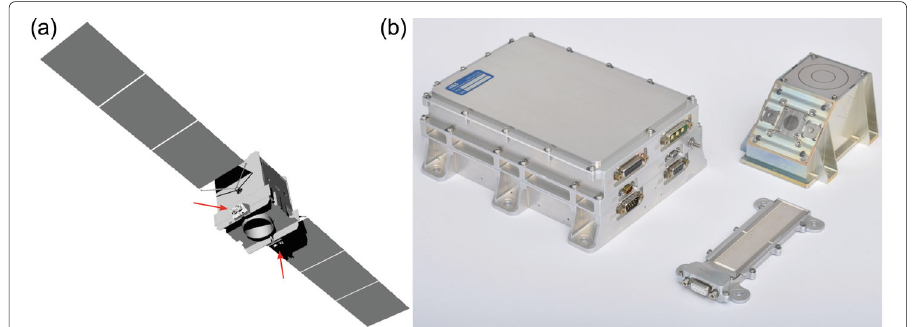
Fig. 1 The EPDP on the Heinrich Hertz satellite. (a) This drawing shows the Heinrich Hertz satellite consisting of the satellite main body with the conspicuous central tube, the solar arrays for power generation, and the two electric thruster pairs for station keeping. The red arrows indicate the two thruster pairs, each pair consisting of a HEMPT and a Hall thruster. (b) The photograph shows the EPDP with the instrument control unit, the plasma sensor, and the erosion sensor in clockwise